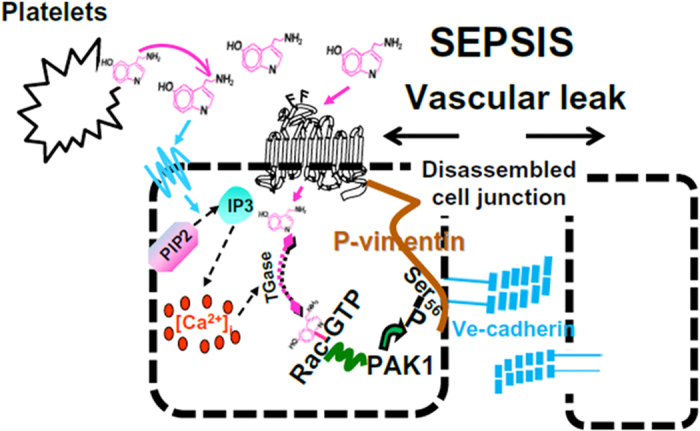
Proposed mechanism by which 5-HT signaling and SERT facilitates endothelial hyperpermeability during sepsis.The data suggest that during, sepsis increased levels of platelet-derived 5-HT initiate intracellular signaling pathways in the endothelial cell, through the activation of TGase and the phosphorylation of vimentin on Ser5622. Following phosphorylation, the curved filamentous structure of vimentin undergoes reorganization and straightens1415. Ve-cadherin binds tightly to P-vimentin and induces a weakening of the cellular junction. This results in vascular microvascular leakage.